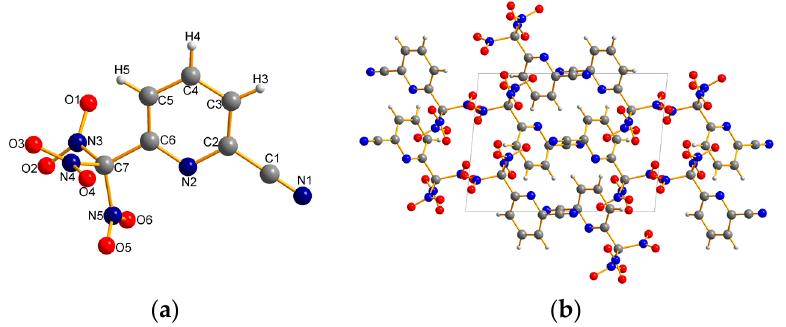
Figure 4. ( a ) Molecular structure of 3 ; ( b ) packing diagram of 3 viewed down the b-axis.